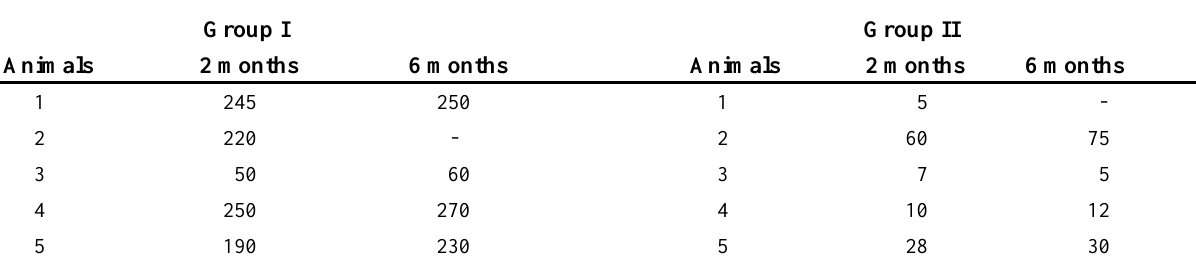
Table 1 – Bladder capacity (mL) of animals from groups I and II at 2 and 6 months.